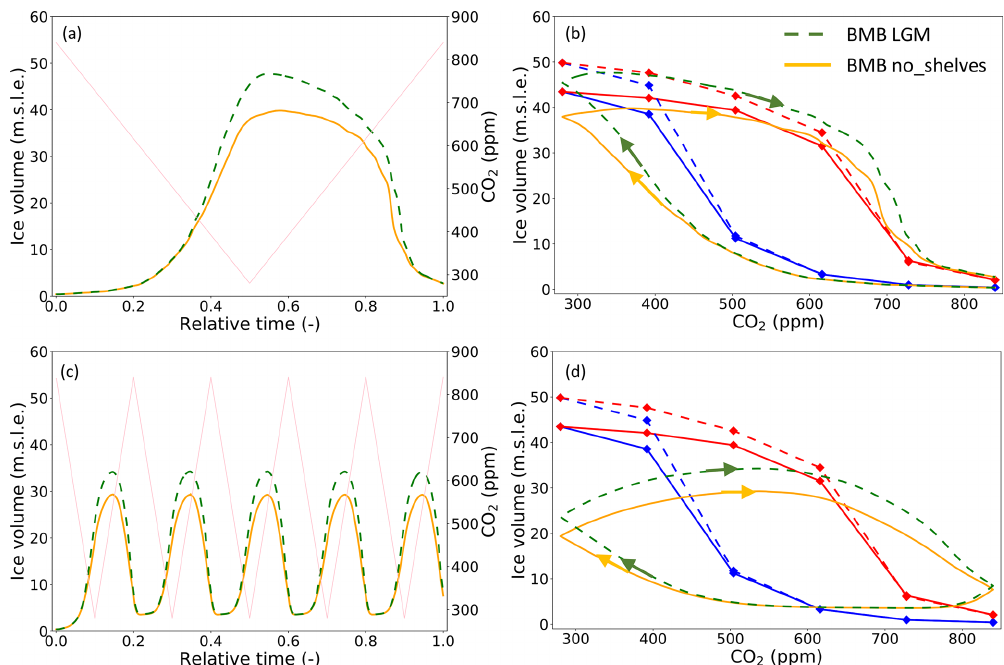
Figure 6. (a) Evolution of forcing CO 2 levels (pink) and ice volume over relative time for the transient 400kyr BMB no_shelves (solid orange) and BMB LGM (dashed green) simulations. (b) Relation between CO 2 and equilibrium ice volume (BMB no_shelves, solid red and blue; BMB LGM, dashed red and blue) and transient ice volume. (c, d) Same for the transient 40kyr simulations. Only the equilibrium cycle (final 40kyr) is shown.